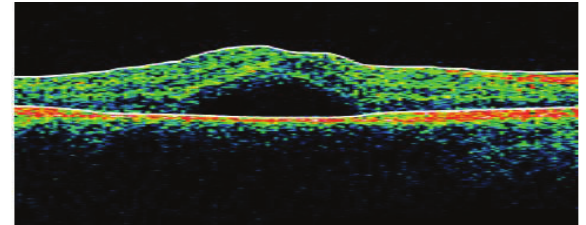
Figure 2: OCT image of the macular serous detachment in the right eye at the time of diagnosis.